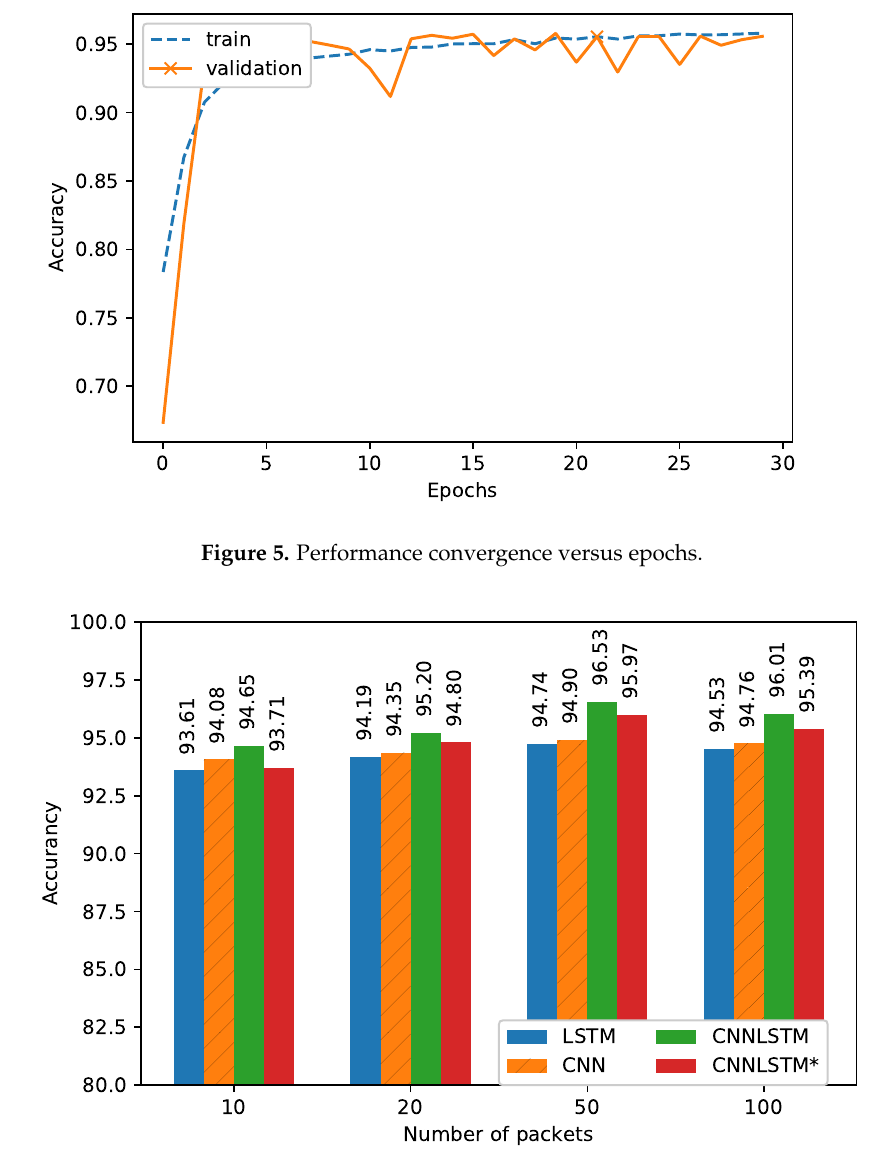
Figure 6. Performances of the models depend on the number of